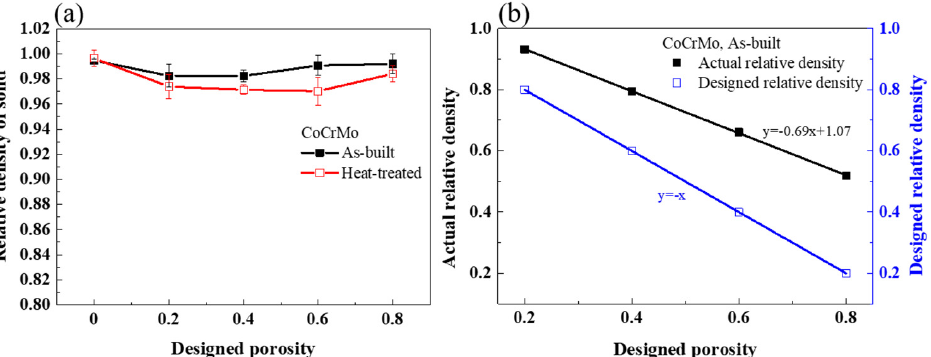
Figure 5. ( a ) The relative density of the solid in the as-built and heat-treated CoCrMo with various designed volume porosities. ( b ) The actual relative density and designed relative density in the as-built CoCrMo with various designed volume porosities.